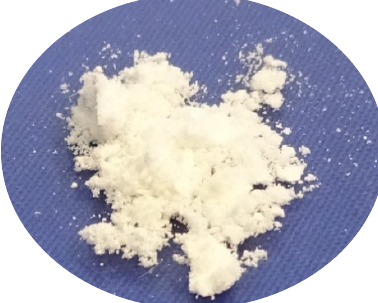
Figure 8. Li 2 CO 3 as a product after precipitation of LiHCO 3 by heating up at 100 °C. The concentration of all other cations, such as Al, Mn, Fe, Co, Ni, and Cu, in sum accounted to <0.17 wt.%. With Li 2 CO 3 purity >99.8 wt.% it was shown that the COOL-Pro-